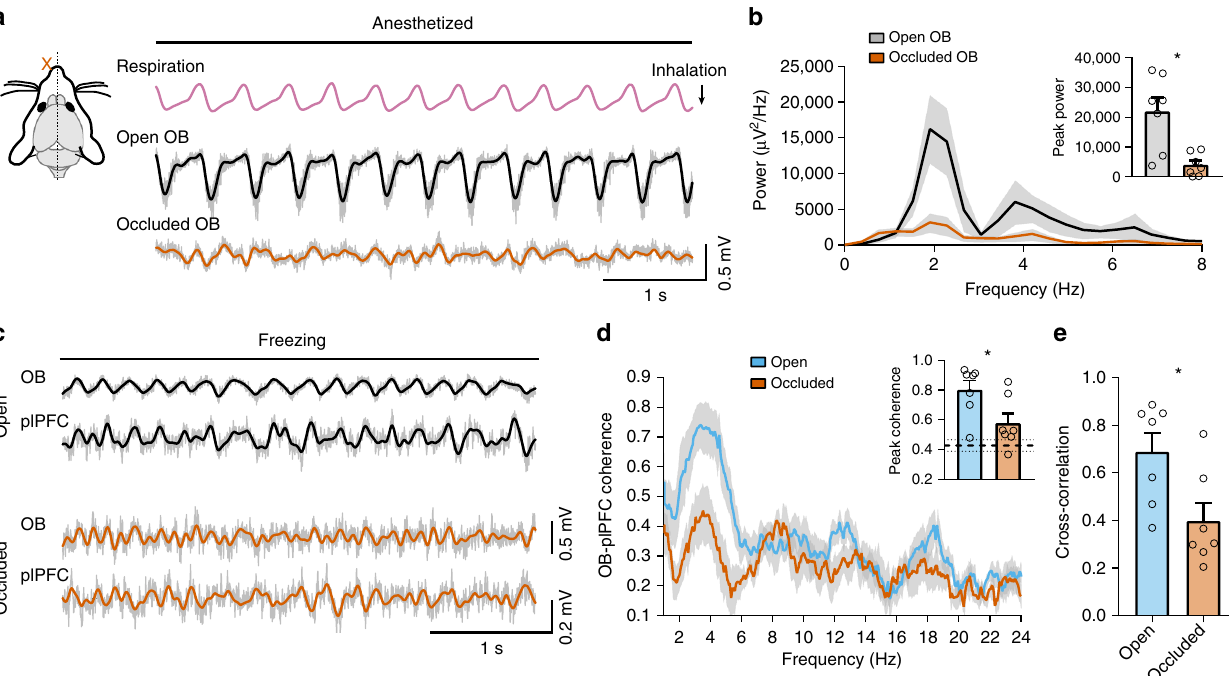
Fig. 3 Respiration-entrained olfactory signals contribute to the 4-Hz rhythm in the plPFC. a Unilateral naris occlusion impairs ascending signals from the olfactory system. Occlusion could be con fi rmed by the reduction of respiration-entrained oscillations in the OB, especially in the anesthetized state. Filtered signals (2 – 6 Hz) are overlaid on raw traces (gray), which also applies to ( c ). b Power spectral density of OB LFPs from open and occluded sides under anesthesia. Inset, averaged peak power of the OBs from open vs occluded sides (21987± 4716 vs 4993 ± 1452, n = 7, paired two-tailed Student ’ s t test t (6) = 3.662, p = 0.011). Note that the breathing rate was at ~2 Hz under anesthesia. c Bilateral OB and plPFC LFP recordings from a naris-occluded mouse during freezing in the fear retrieval session. d Spectral coherence between simultaneously recorded OB and plPFC LFPs during freezing periods on the open vs occluded sides (mean± SEM, n = 7 mice). Inset, averaged peak coherence between the OB and plPFC LFPs for open and closed sides (0.80 ± 0. 06 to 0.58 ± 0.07, n = 7, paired two-tailed Student ’ s t test t(6) = 3.211, p = 0.018). The average peak coherence between plPFC and shuf fl ed OB signals from the occluded side is 0.42, indicated by the thick dashed line (the two thin dashed lines indicate the standard errors). e The occluded side shows a decrease in the OB-plPFC cross-correlation compared to the open side during freezing (0.69 ± 0.08 open vs 0.40 ± 0.08 occluded, n = 7, paired two-tailed Student ’ s t test t (6) = 3.353, p =